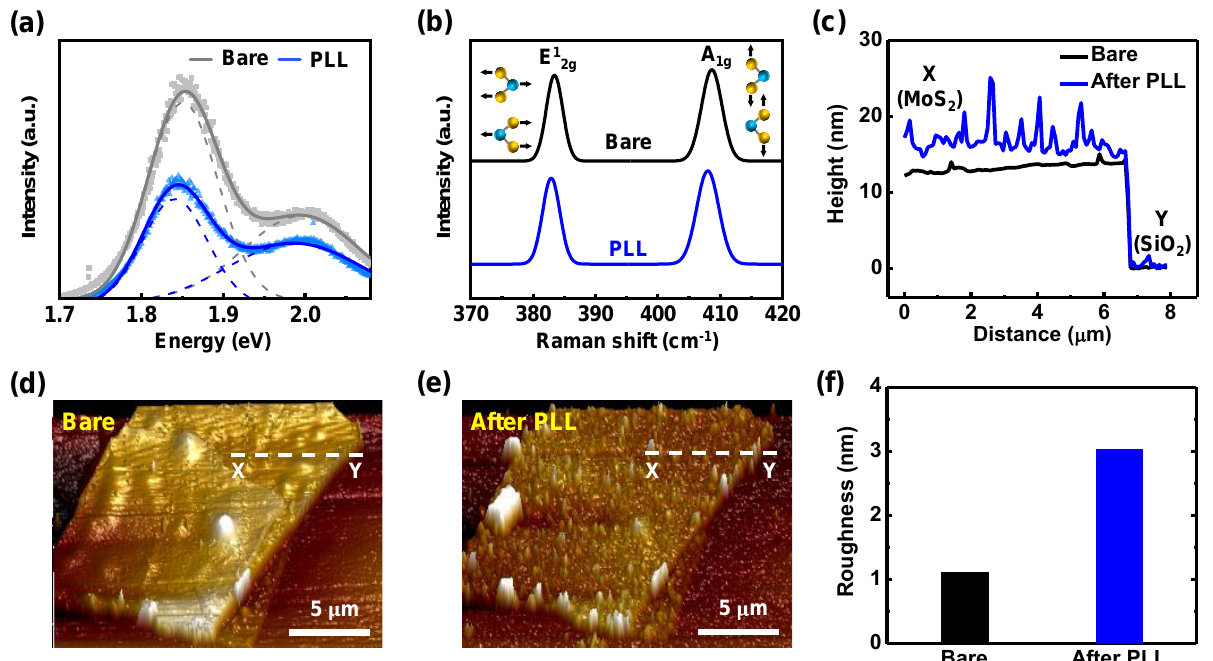
Figure 7. ( a ) Photoluminescence (PL) characteristics of m-MoS 2 flakes before and after PLL treatment; ( b ) evolution of Raman spectra of m-MoS 2 corresponding to bare condition and PLL treatment; ( c ) Height profile of m-MoS 2 flakes measured by AFM before and after PLL treatment. X and Y denote MoS 2 and SiO 2 region, respectively; ( d ) AFM topographical images of m-MoS 2 flake for ( d ) bare condition and ( e ) PLL treatment. Dashed line indicates extracted points to obtain height profile in Figure 7c; ( f ) evolution of surface roughness of the m-MoS 2 flakes extracted from the AFM topography. The Surface roughness increased via attached molecules after PLL treatment.